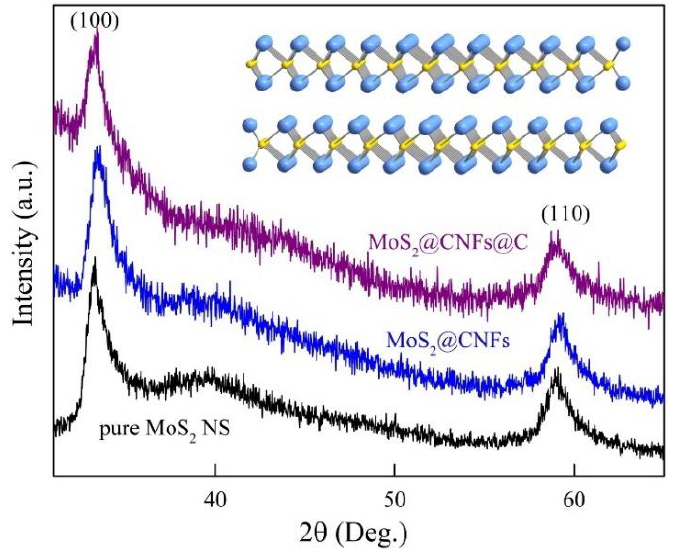
Figure 2. The XRD patterns of pure MoS 2 NS, MoS 2 @CNFs, and MoS 2 @CNFs@C. The inset is the simulated crystal structures of MoS 2 .